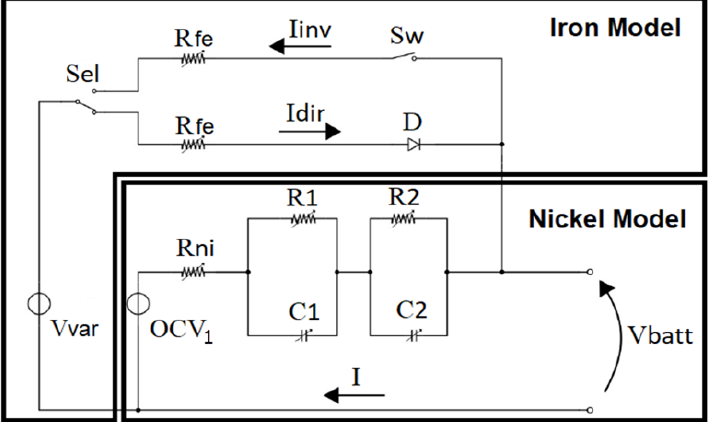
Figure 4. Advanced electrical model of SMHB including iron-doping